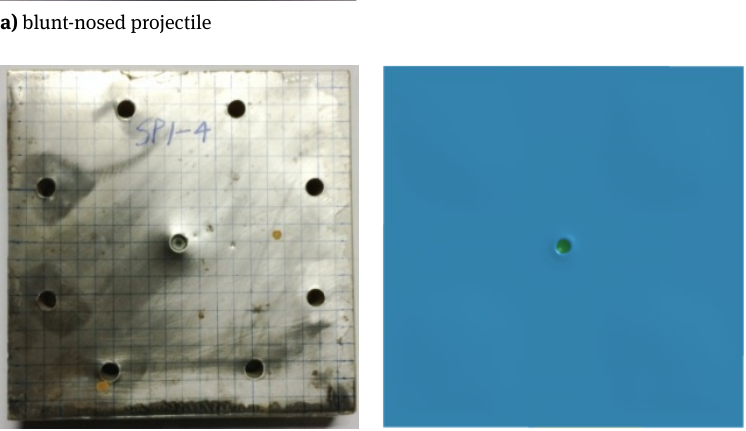
Figure 9: Experimental mode and numerical mode of steel/nylon sandwich